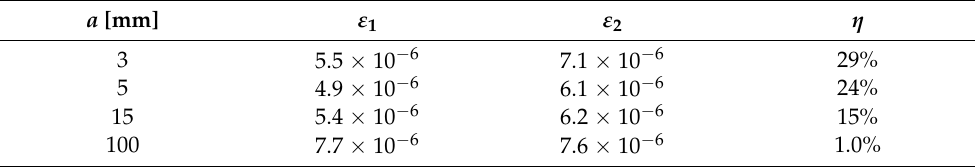
Table 3. Relationship between the size of the polydimethylsiloxane (PDMS) cube and the strains induced in the pair of beams for Beam E.